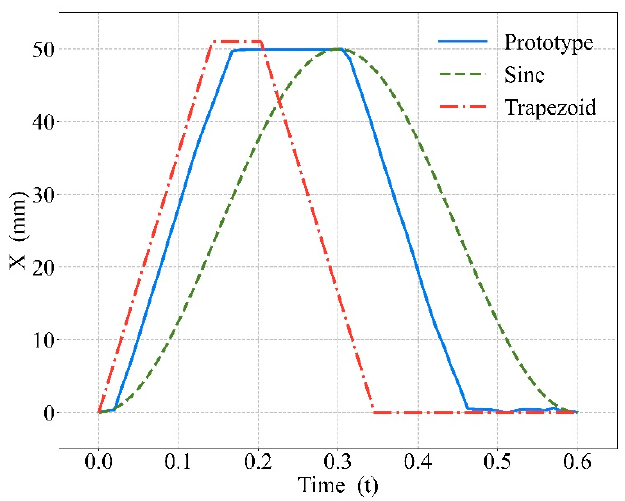
Figure 10. Various compression waveforms.